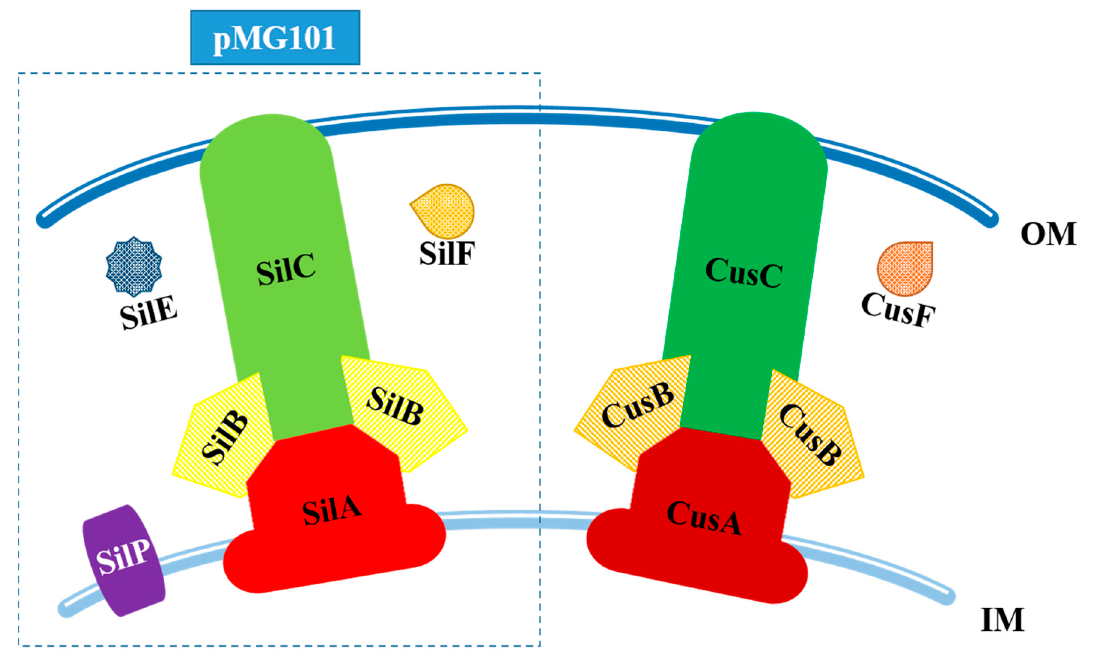
Figure 5. A comparison of the Sil (pMG101) and Cus silver resistance systems in Gram-negative bacteria, IM—inner membrane, OM—outer membrane.